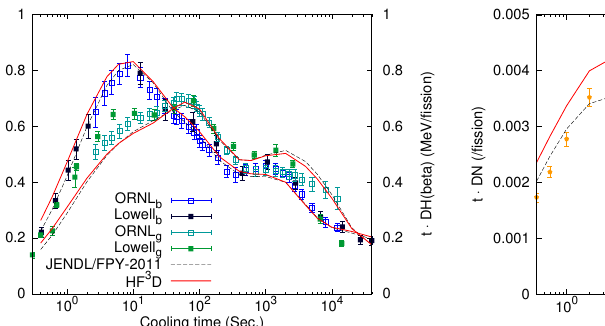
Figure 4. Cooling time dependence of the decay heats by β (b) and γ (g) emissions comparing with the experimental data for 235 U(n th ,f).